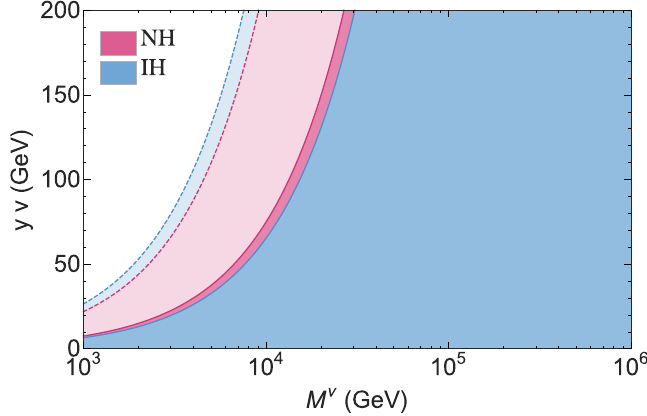
Figure 3 . Allowed region of the free parameters y and M (cid:23) in the minimal scenario when the present bound [63] on (cid:22) e(cid:13) is considered. For each hierarchy, the boundary ranges from the solid ! to the dashed line depending on the values of the phases (cid:14) and (cid:11) . The pink region corresponds to NH while the blue region corresponds to